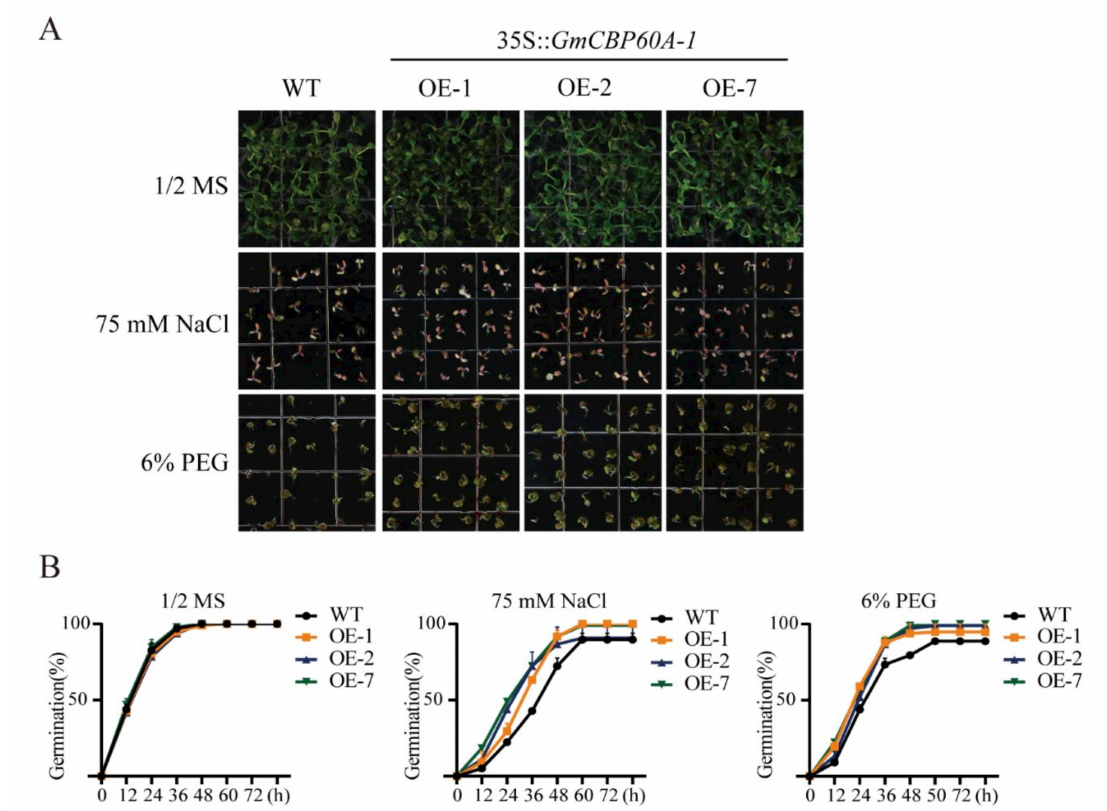
Figure 5. The seed germination of transgenic Arabidopsis lines and WT plants under NaCl and PEG treatments and the results of related statistics. ( A ) The seeds of transgenic lines and WT plants were grown in 1/2 MS, 1/2 MS containing 75 mM NaCl and 1/2 MS containing 6% PEG. ( B ) The line chart of germination under different conditions. Three biological replicates were performed, and the values are means ± SD. Values marked with similar letters indicate not statistically significant differences (Student’s t- test: p ≤